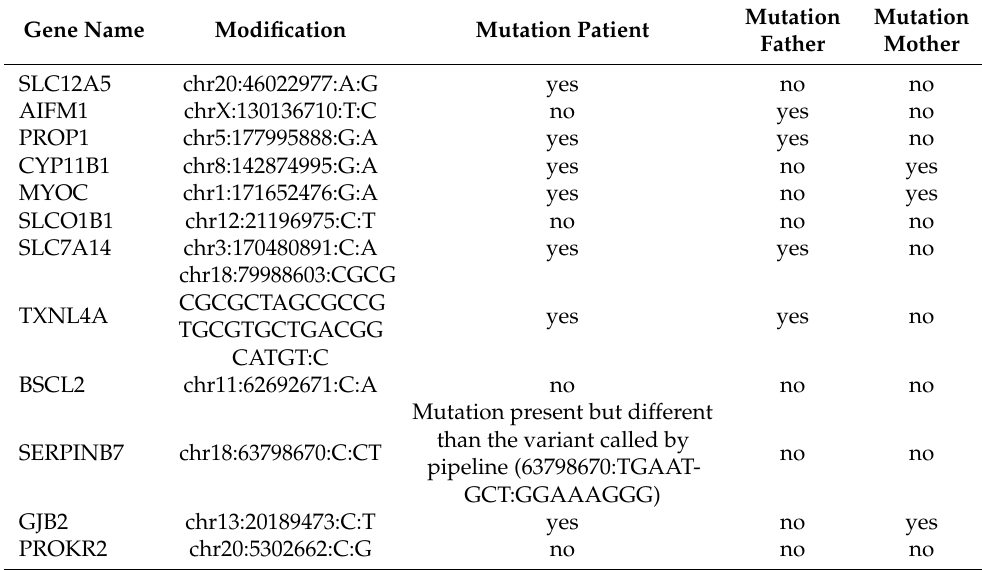
Table A2. Variants with parental origins versus de novo mutations based on Sanger